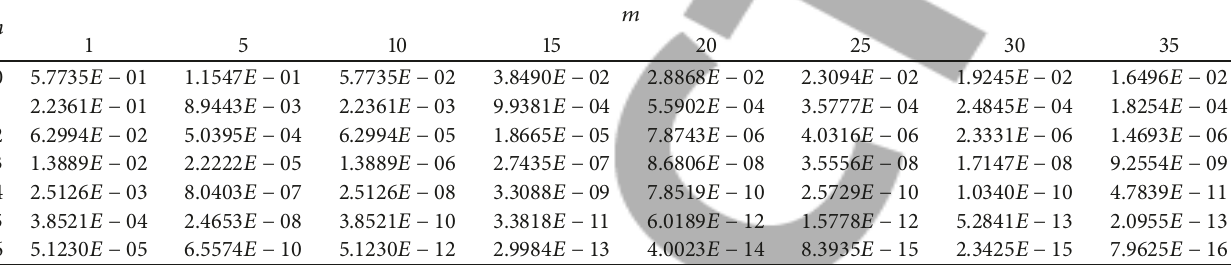
Table 3: Maximum absolute errors for different values of 𝑛 and 𝑚 for Example